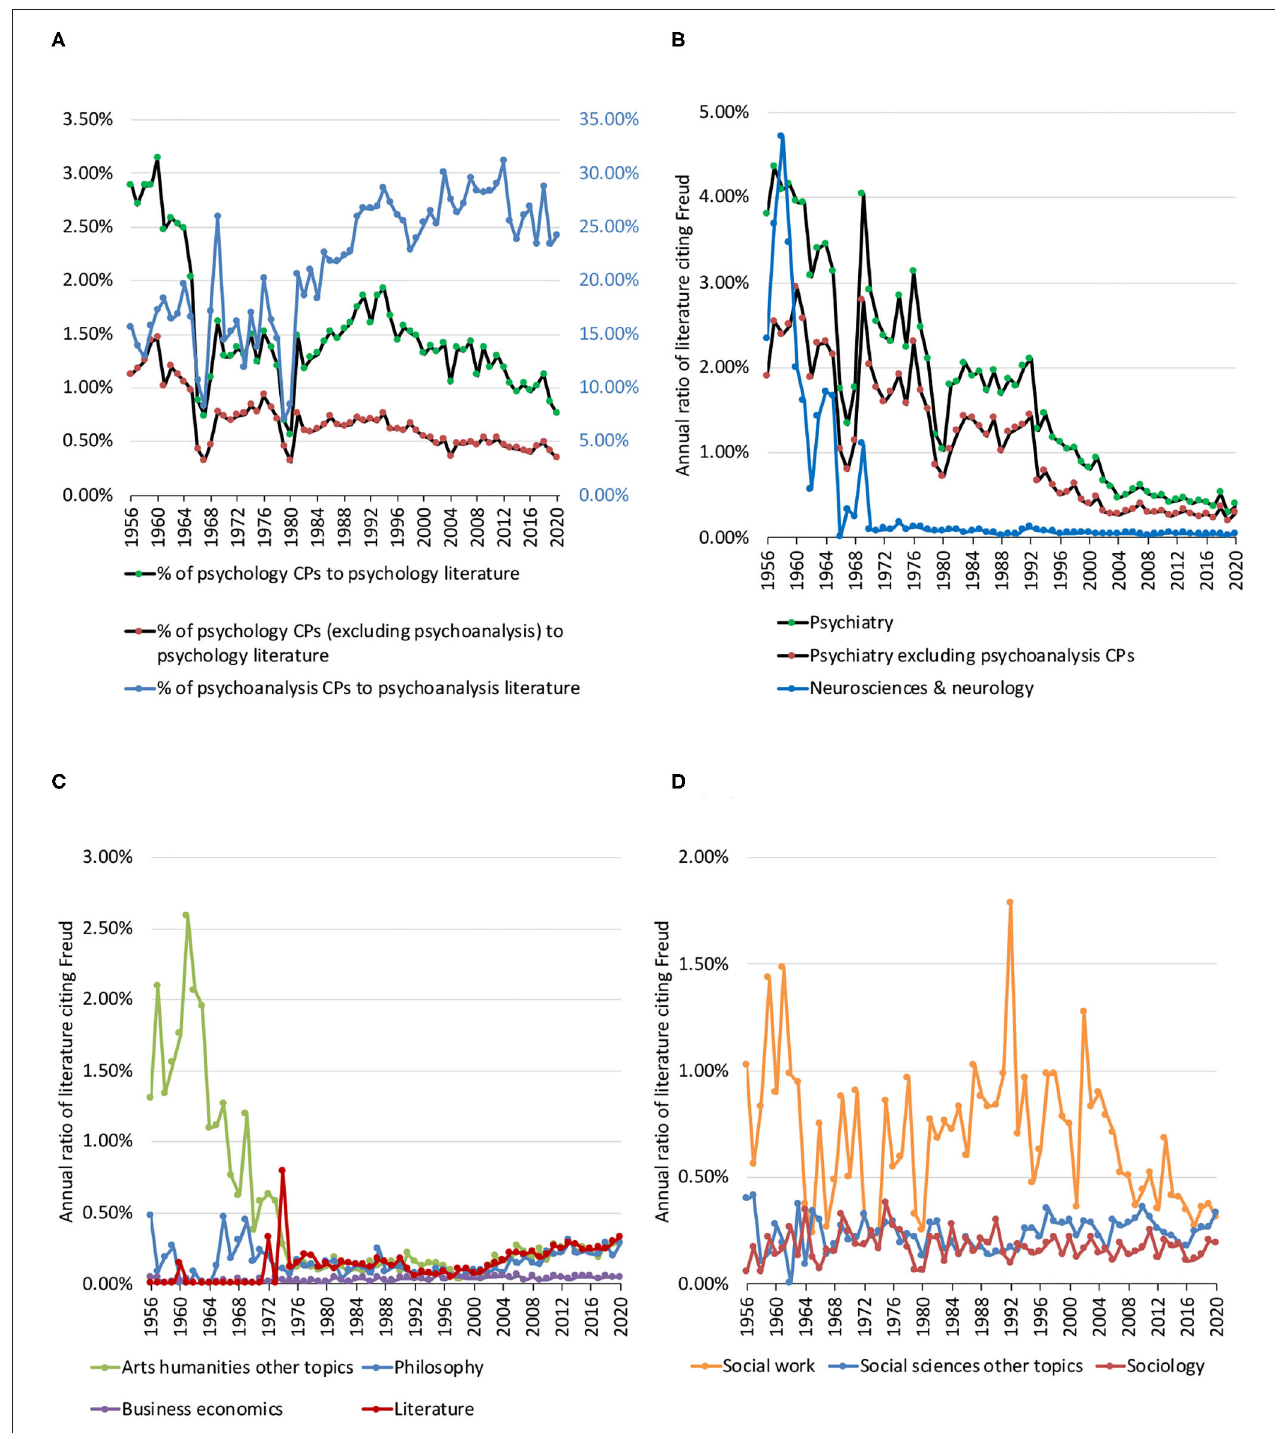
FIGURE 1 | (A) Percentage of psychology papers citing Freud. Green dots indicate the overall percentage of psychology citing papers (CPs) to overall psychology literature. Red dots indicate the percentage, excluding CPs in psychoanalysis journals. Blue dots indicate the percentage of psychoanalysis CPs to psychoanalysis literature. (B) Percentage of psychiatry and neuroscience papers citing Freud. Green dots indicate the overall percentage. Red dots indicate the percentage, excluding psychiatry CPs also assigned to the category of psychoanalysis. Blue dots indicate the percentage of neurosciences and neurology. (C) Percentage of arts